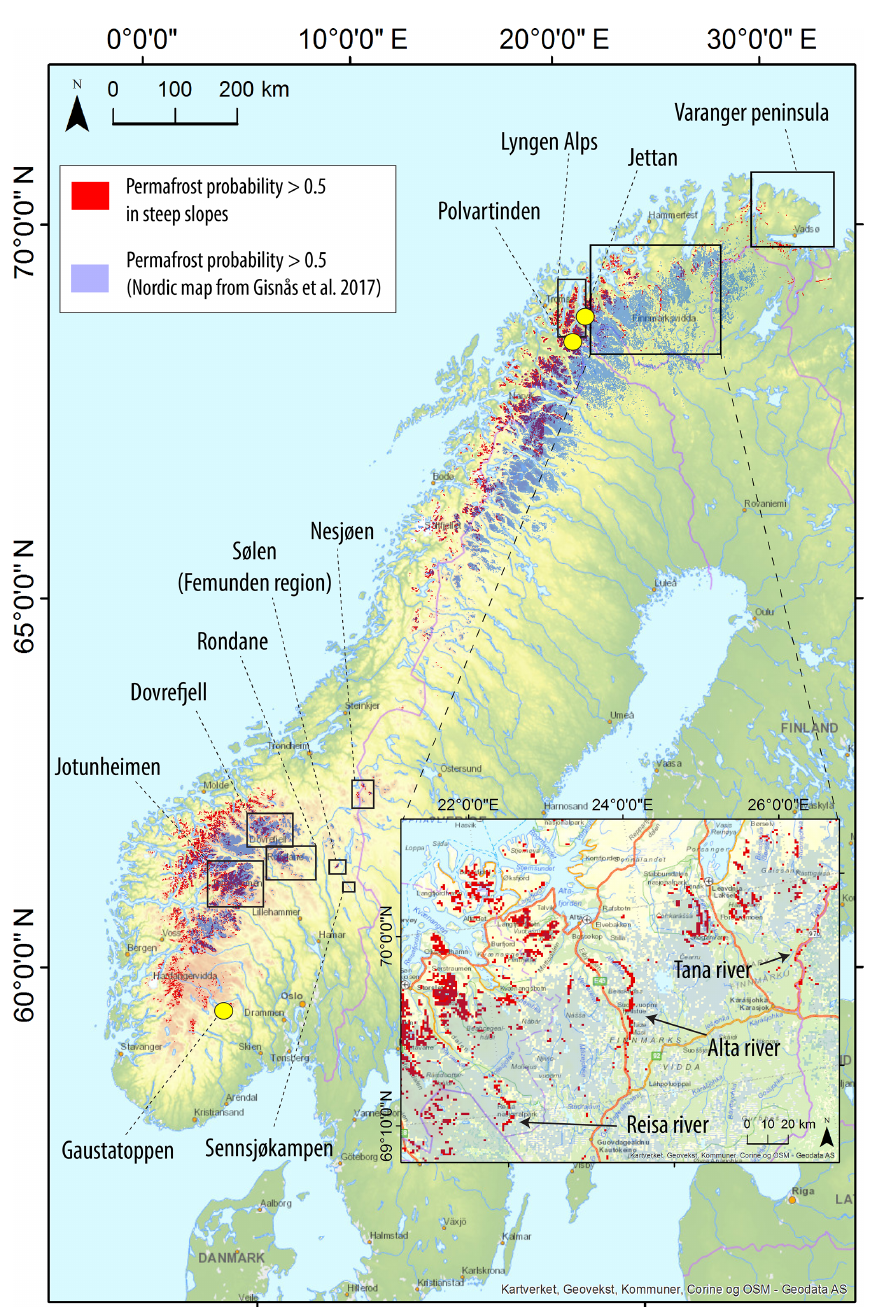
Figure 11. Permafrost distribution in steep rock slopes of Norway according to the CryoWall map and in Scandinavia according to the map produced by Gisnås et al. (2017). For steep rock slope permafrost, only the discontinuous and continuous permafrost classes are displayed as the lower limit of discontinuous permafrost corresponds to the 0 ◦ C isotherm and covers the main permafrost areas. Areas of interest for the discussion are